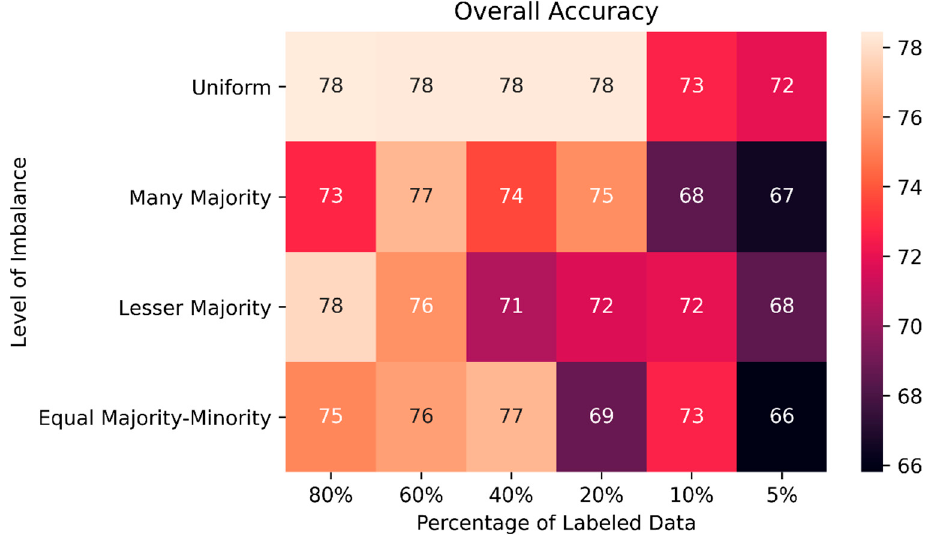
Figure 4. Overall top-1 accuracy of FixMatch for varied labeled samples and 4 levels of imbalance.